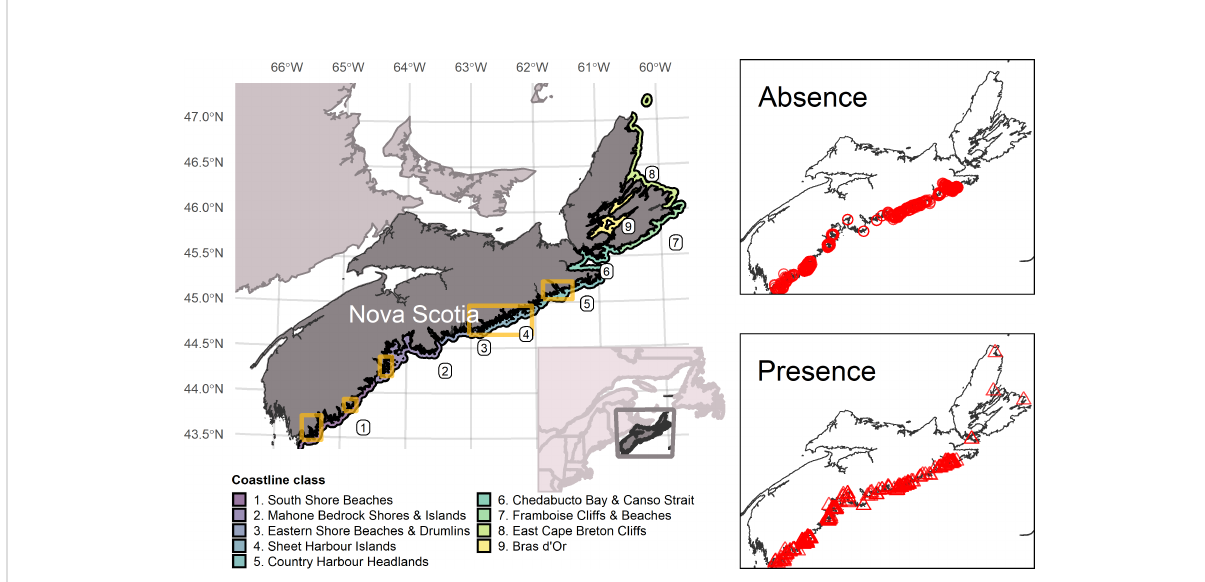
FIGURE 1 Study area extent along the Atlantic coast of Nova Scotia and locations of eelgrass presence − absence observations used in model calibration. Coloured polygons (left panel) are coastline classes delineating regions of differing physiographic and oceanographic nearshore conditions. Yellow boxes identify 5 areas sampled by drop camera surveys from 2019 – 2021. Red points (right panels) are the locations of eelgrass observations (circles = absent, triangles =